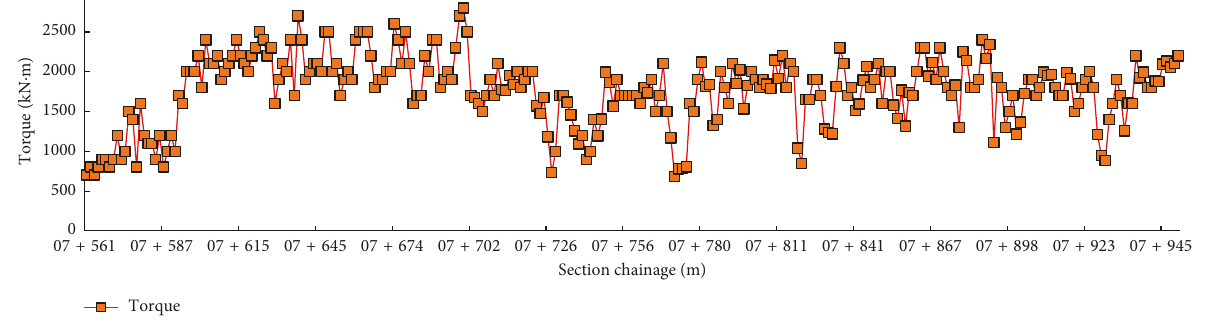
Figure 12: The recorded torque along the Neelum–Jhelum TBM diversion tunnel.